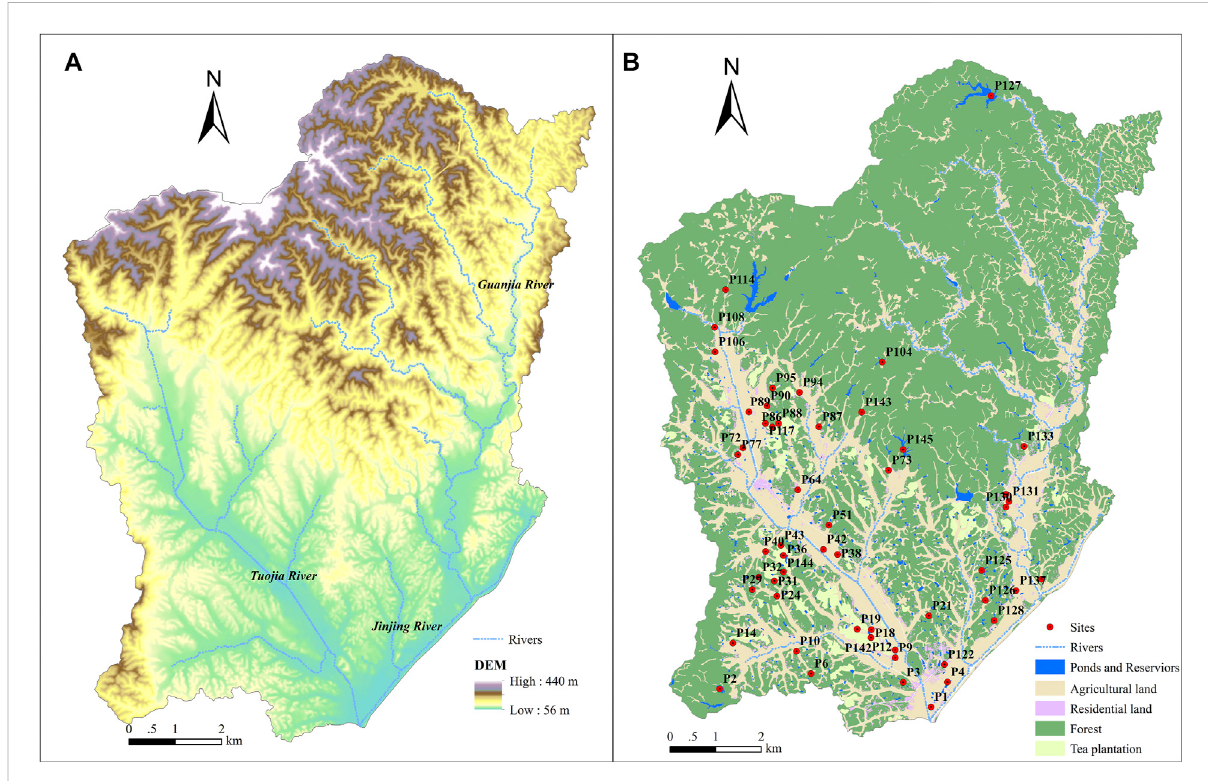
FIGURE 1 Distribution of rivers and elevation in Jinjing watershed (A) and distribution of land use types and sampling sites (B) in Jinjing